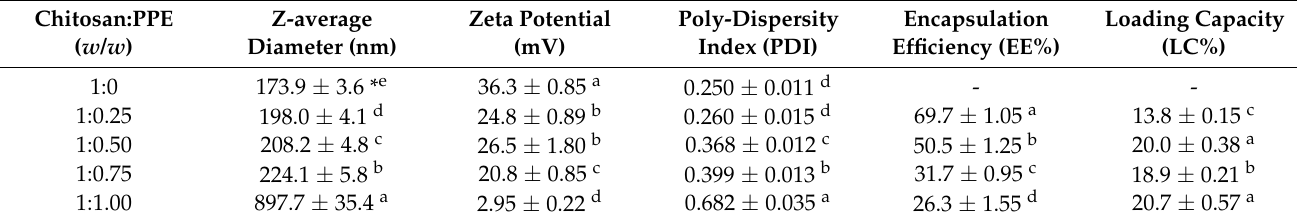
Table 3. Effect of PPE loading at different concentrations on average diameter, zeta potential (ZP), and poly-dispersity index (PDI) of